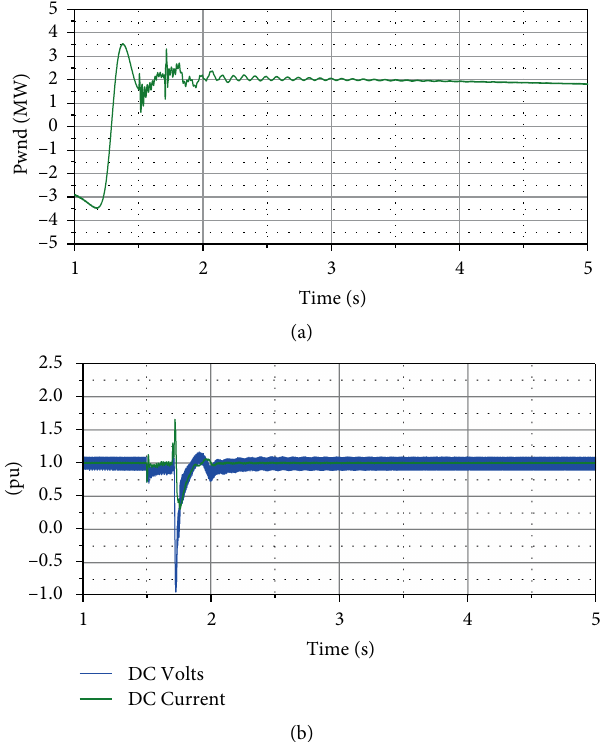
Figure 19: Evolution of the proposed network to demonstrate the SSR effect reduction on. (a) Power flow characteristics in the wind farm. (b) DC voltage and current response in the